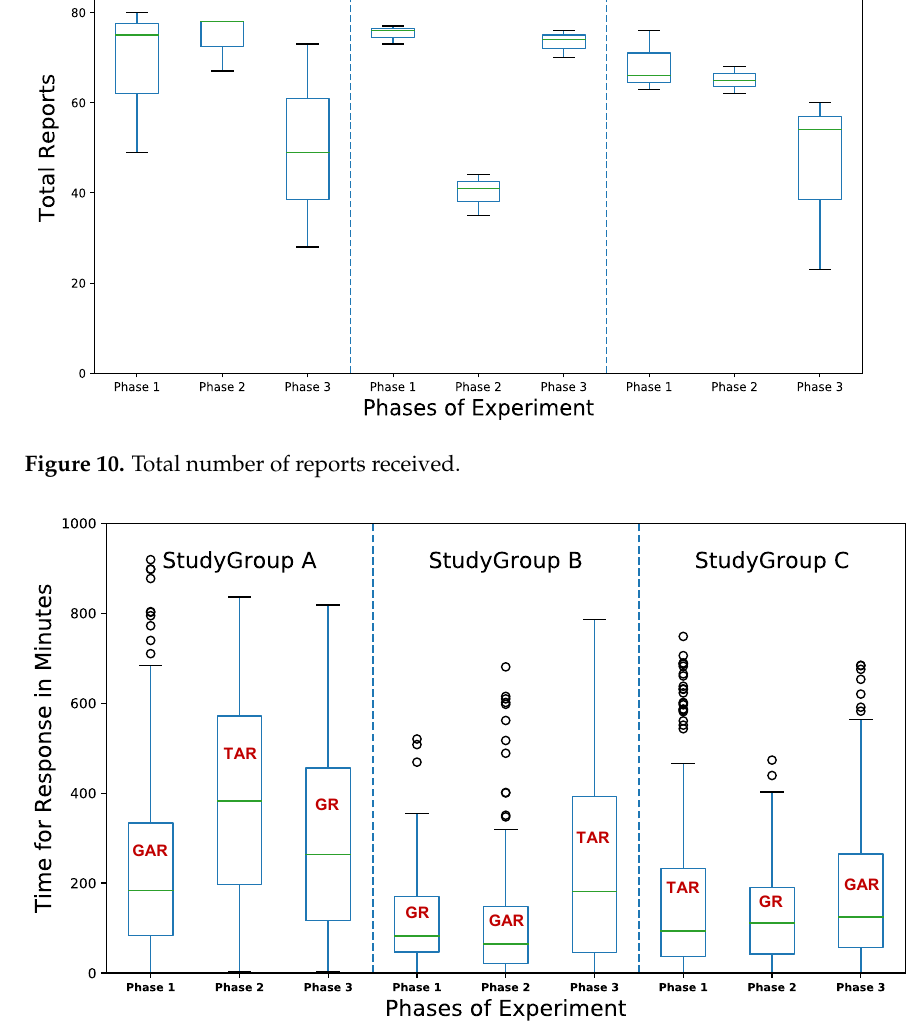
Figure 11. Response time for activities per phase based on study